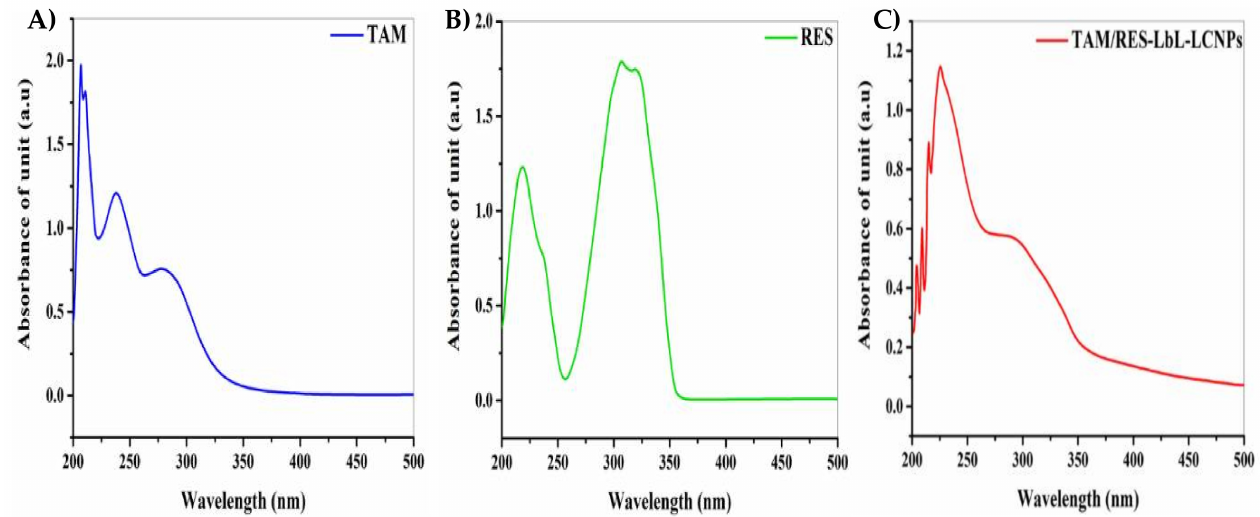
Figure 3. UV–vis spectroscopy analysis of ( A ) TAM, ( B ) RES, and ( C )